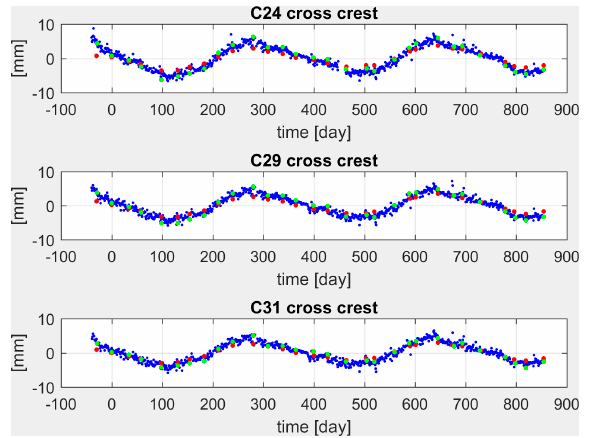
Figure 6. Displacements estimated on ashlars 24 ( top ), 29 ( center ), 31 ( bottom ) by pendulums (red dots) and GNSS (blue dots) in the cross-crest direction (green dots represent the collimator observations) from October 2014 to April 2017.